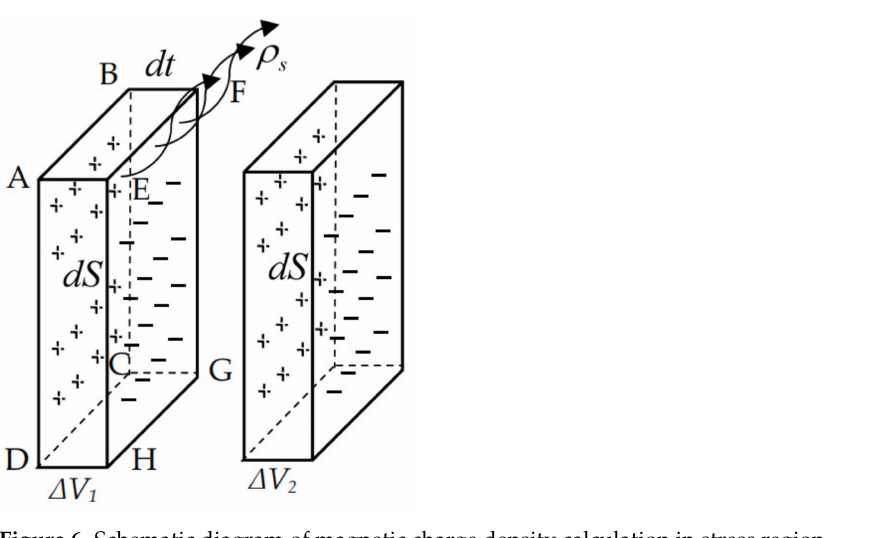
Figure 6. Schematic diagram of magnetic charge density calculation in stress